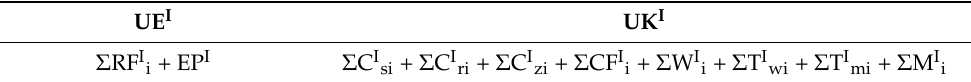
Table 1. Share of UE I ecological (environmental) and UK I economic costs.